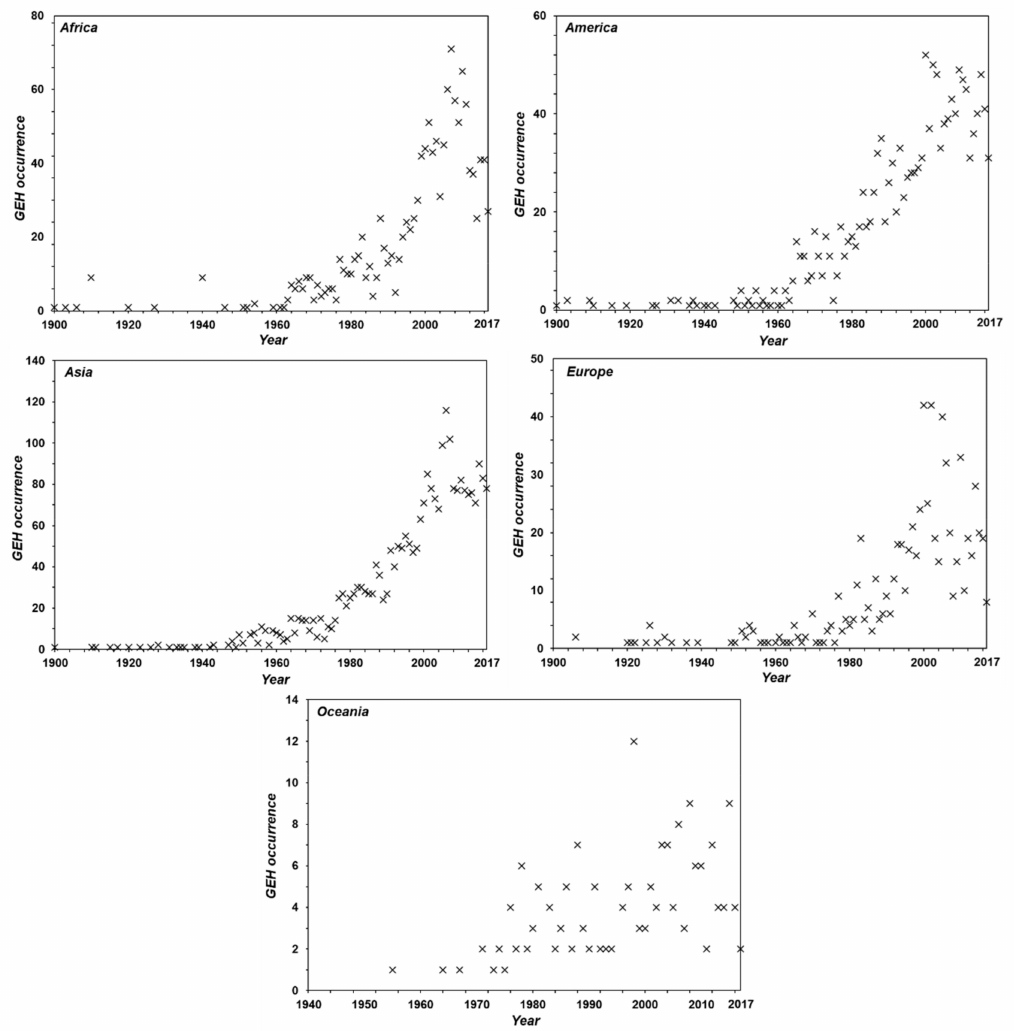
Figure 7. Geotechnical engineering hazard occurrence by continent from 1900–2017. Reproduced with permission from the Centre for Research on the Epidemiology of Disasters (CRED), Emergency Events Database (EM-DAT); published by the Universit é catholique de Louvain (UCL)